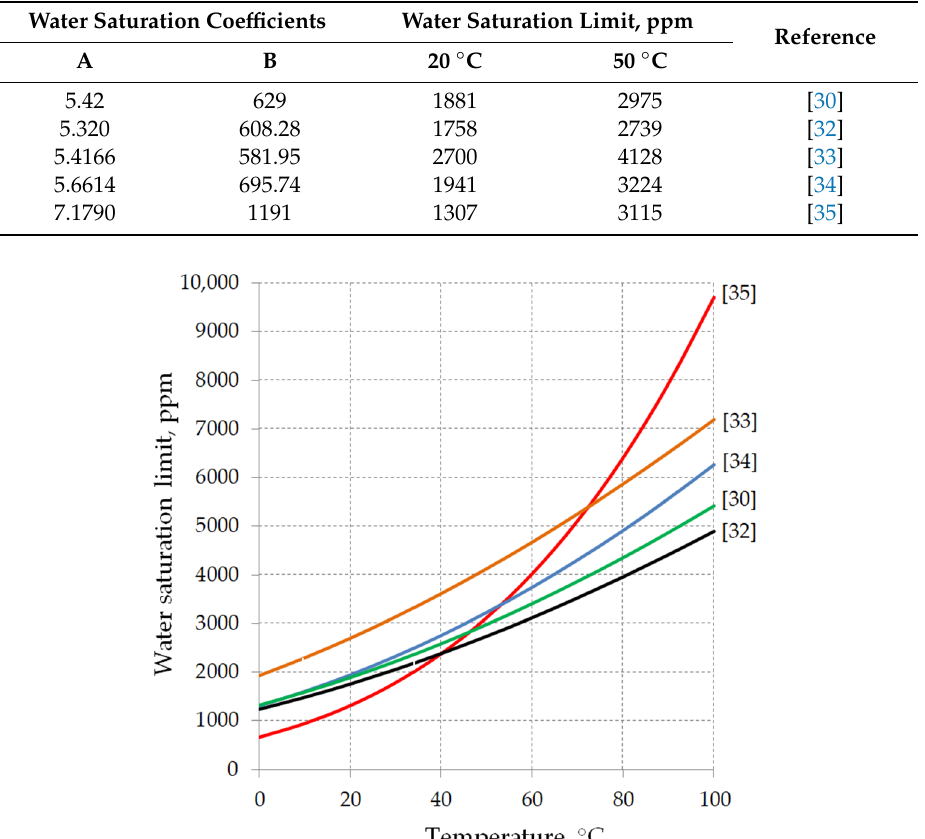
Table 2. Water saturation coe ffi cients for synthetic ester Midel 7131.